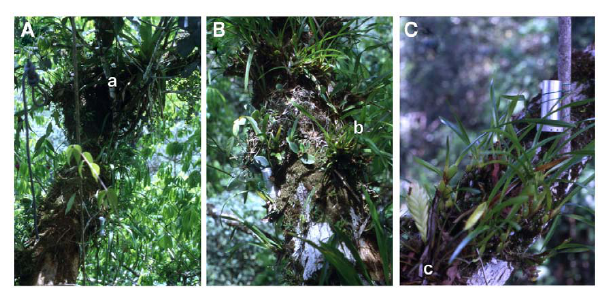
FIGURE 1 | Habitat on the upper branches of the host tree Virola michelii Heckel. The pictures were taken between 38 and 41m above ground. (A) Overview picture of a representative branch of V. michelii in the upper canopy (height 41m).The branches are densely covered by vascular epiphytes that accumulated a substrate layer on the branches.The dominating species is Maxillaria alba (Hook. f.) Lindl. (B) Close-up view of the same branch showing several orchid species growing next to each other. Additionally, the spatial pattern of different light intensity becomes obvious, those light fleckles were highly fluctuating because of moving clouds and leaves. (C) Custom made light sensor (metal capsule), that was placed in close proximity to the plants for continuous recording of light intensity. Selected species, which were included in this study, are also visible in this panel: Clusia grandiflora Engl. (a), Maxillaria alba (Hook. f.) Lindl. (b), and Tillandsia anceps Lodd.